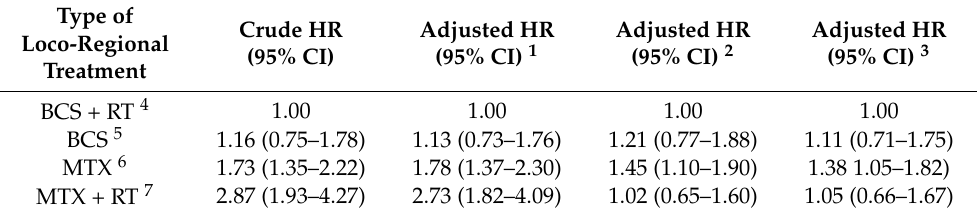
Table 3. Hazard ratios (HR) for breast cancer-specific mortality from competing risks analysis.